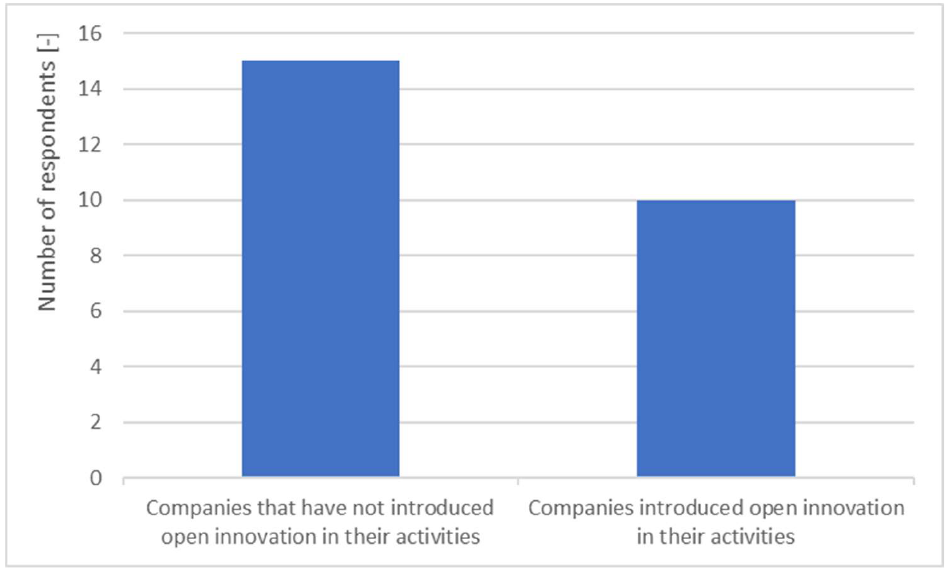
Figure 4. The ratio of companies with implemented open innovations to those not implemented.